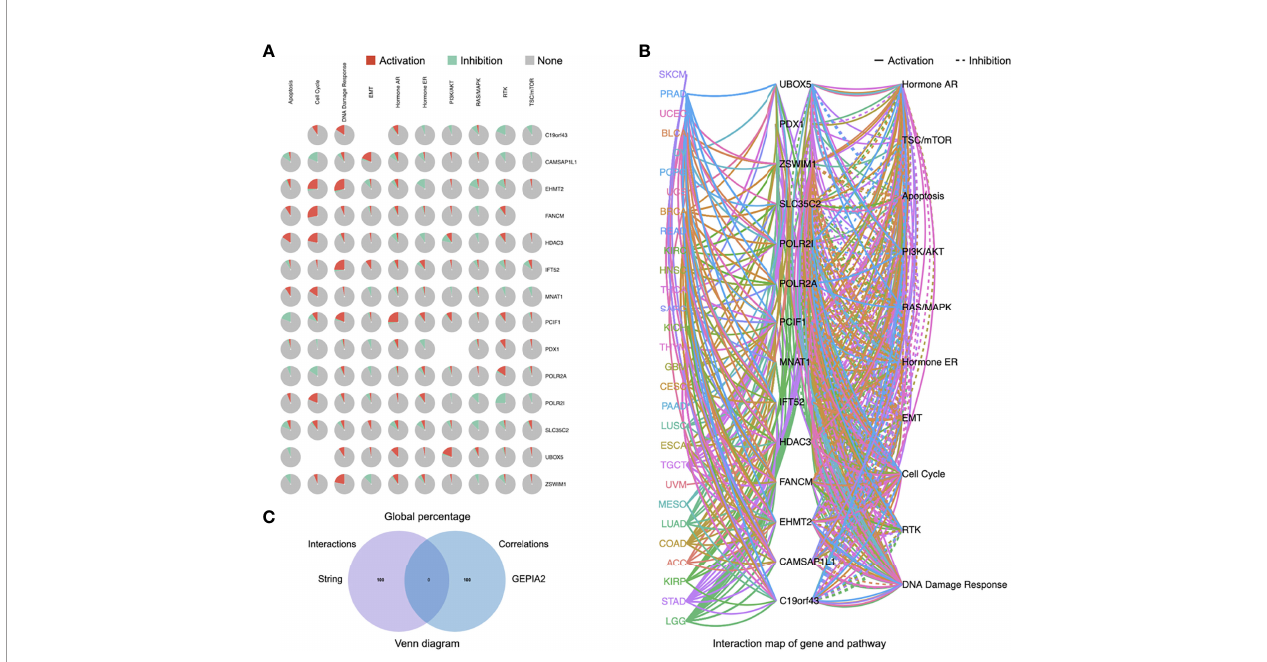
FIGURE 9 | Pathway activity of eight PCIF1-correlated proteins and fi ve PCIF1-interacted genes. (A, B) Global percentage and interaction map of gene and pathway of PCIF1, eight PCIF1-binding proteins (PDX1, MNAT1, HDAC3, POLR2A, POLR2I, CAMSAP2, C19orf43, FANCM), and top 5 correlated genes. (C) Venn diagram showed there was no overlap between PCIF1-interacted proteins and PCIF1-correlated